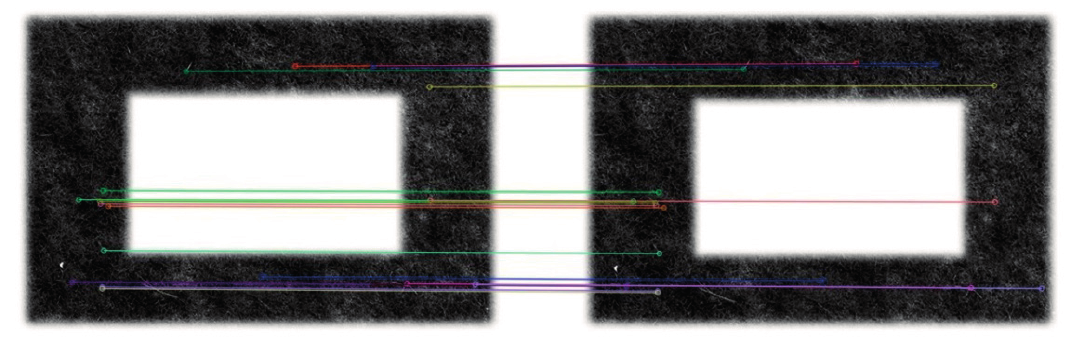
Figure 5. The matching result of two frames. The lines connect the match points between two